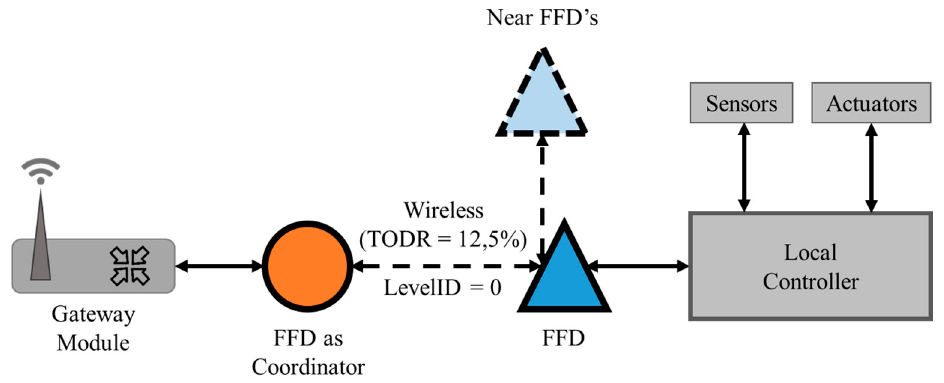
Figure 19. Manufacturing cell interior connections example diagram with TODR value. A manufacturing cell interior and hybrid connections example diagram with TODR values is shown in Figure 20.